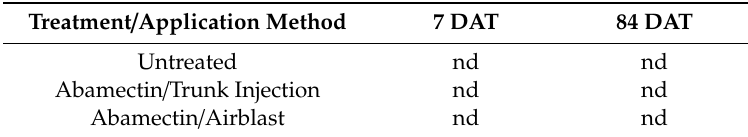
Table 4. Mean abamectin residue on fruit taken 7 days and 84 days after the first treatment (DAT). No residue was detected (nd) above the level of detection (0.001 ppm).